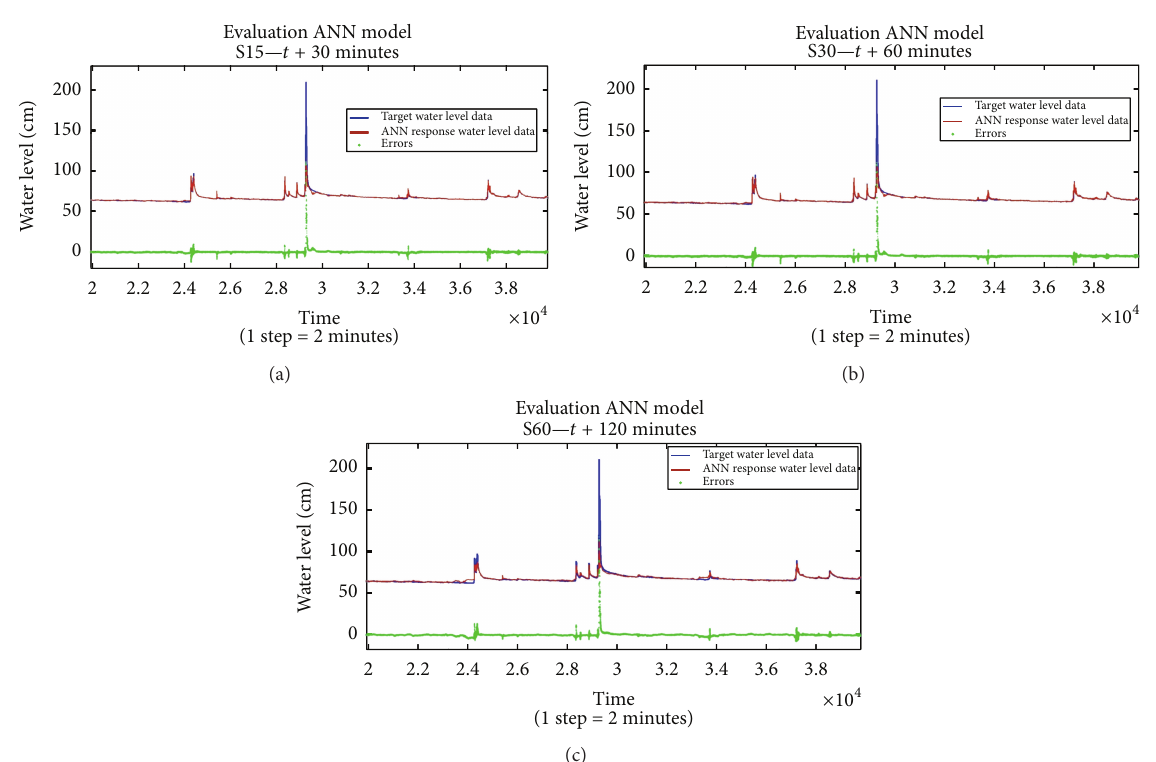
Figure 12: Graphical presentation of the target data and response of the ANN prediction model during evaluation: (a) S15, (b) S30, and (c)